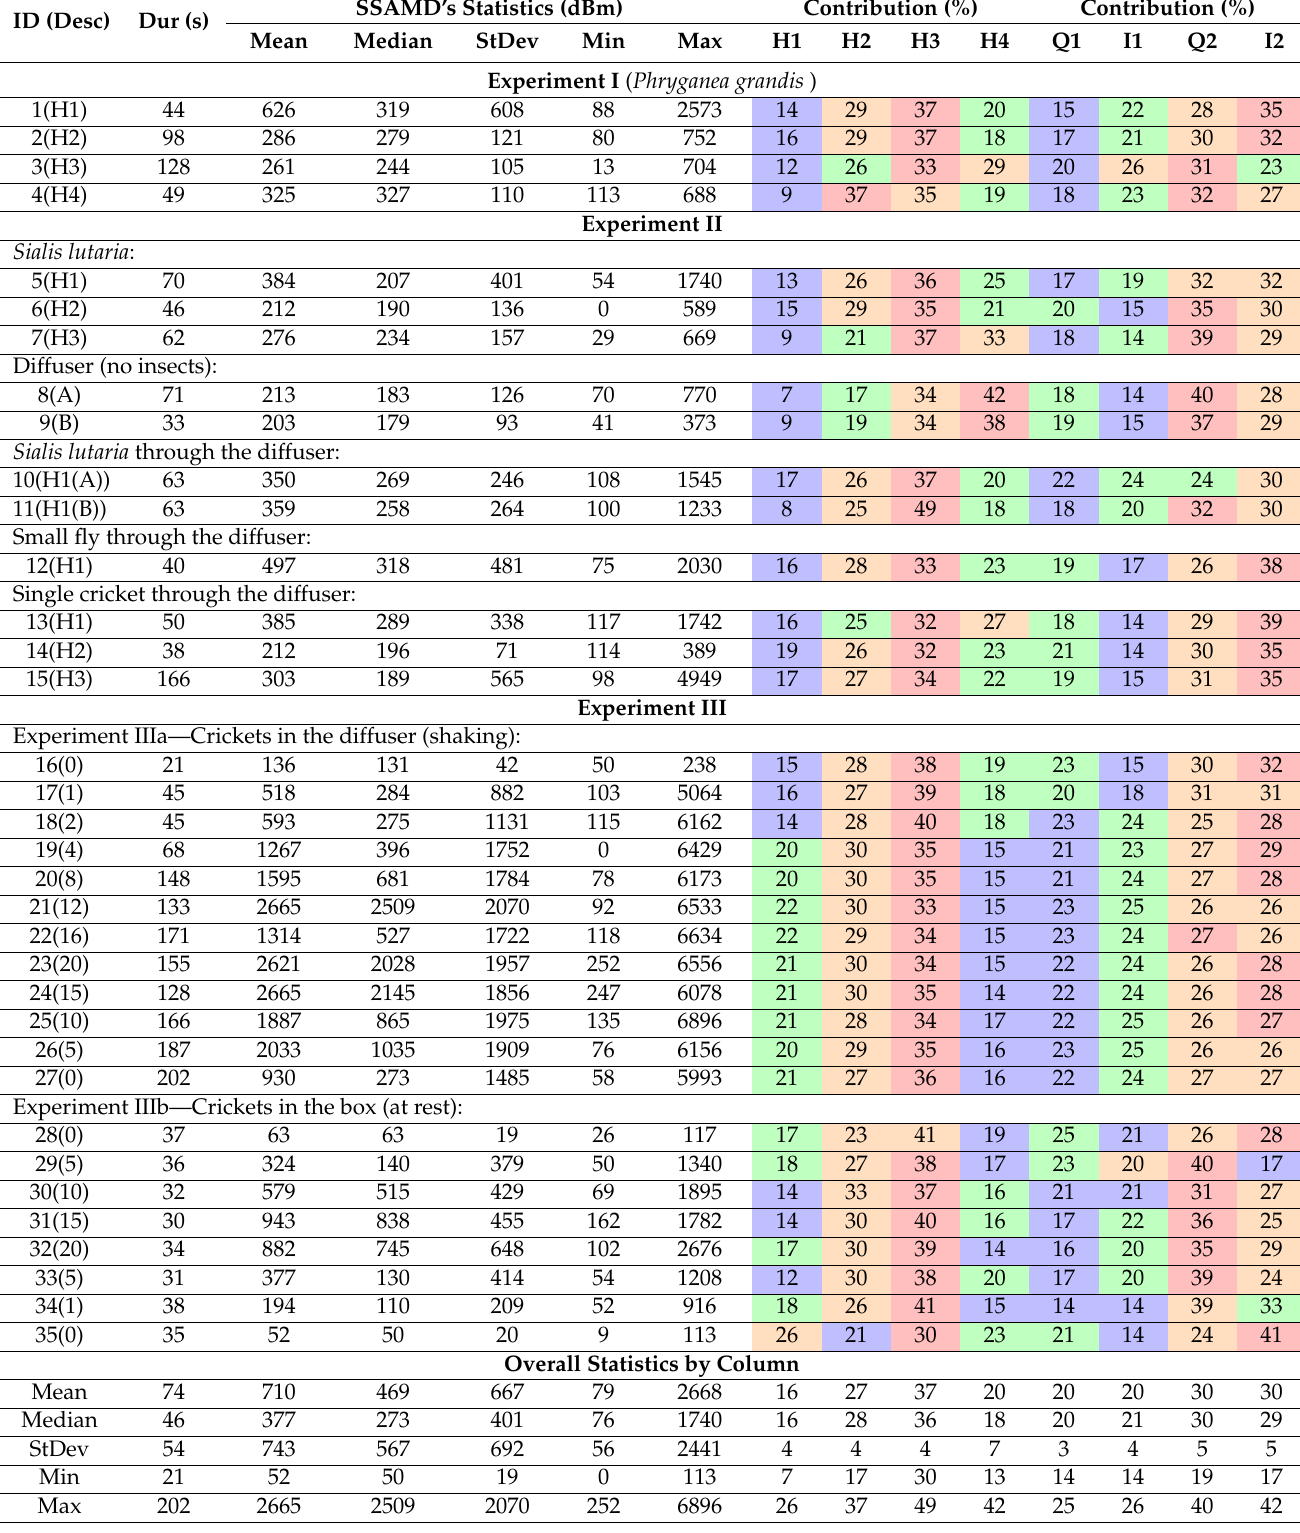
Table 1. Experiments: resulting statistics. Desc—description; Dur—duration; StDev—standard deviation. Blue–green– orange–red cell background colors represent numbers from minimal to maximal values,